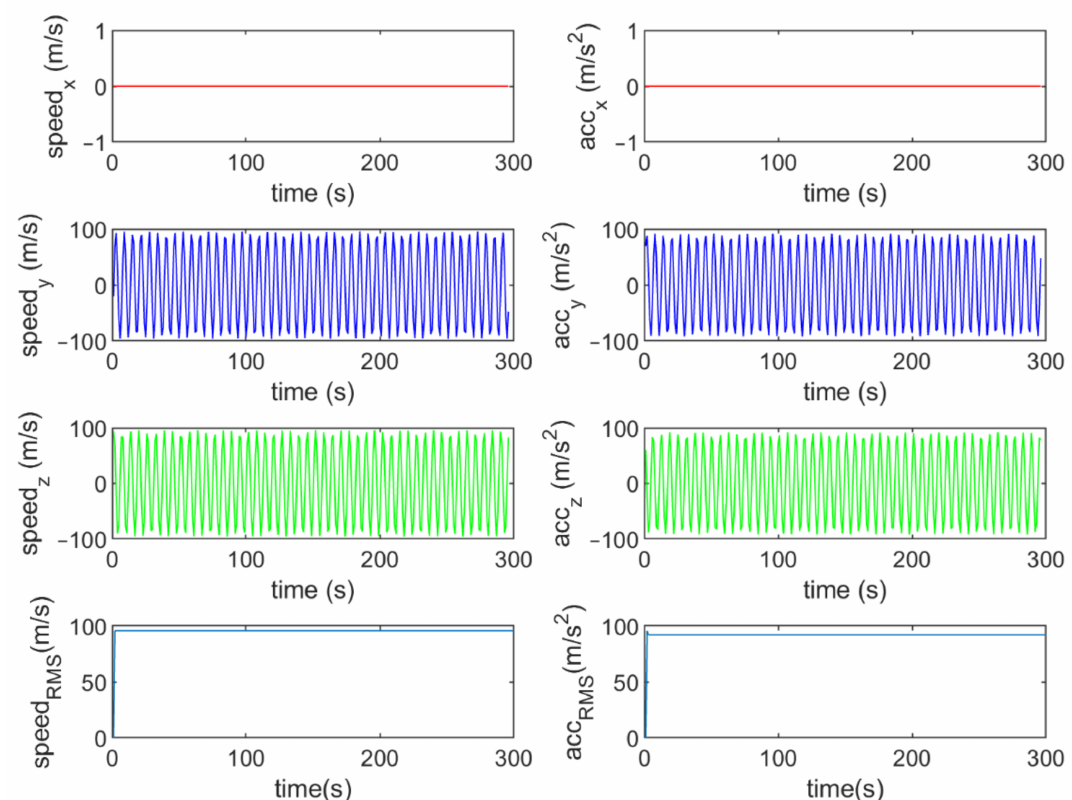
Figure 10. The speed and acceleration components in the first scenario.